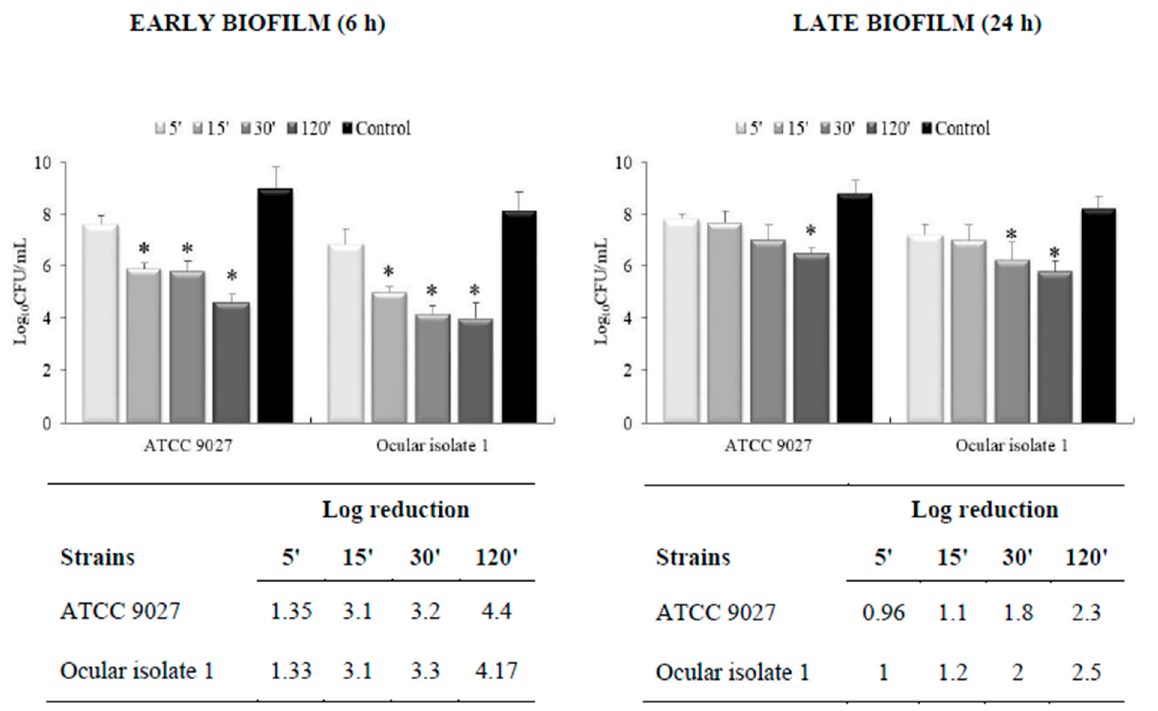
Figure 3. Quantitative measurement of P. aeruginosa biofilm-embedded cells after treatment with CST. Data are expressed as means ±SD of three independent experiments carried out in triplicate and relative Log reduction. *, p -value < 0.05 shows the statistical difference between treated groups and control groups.